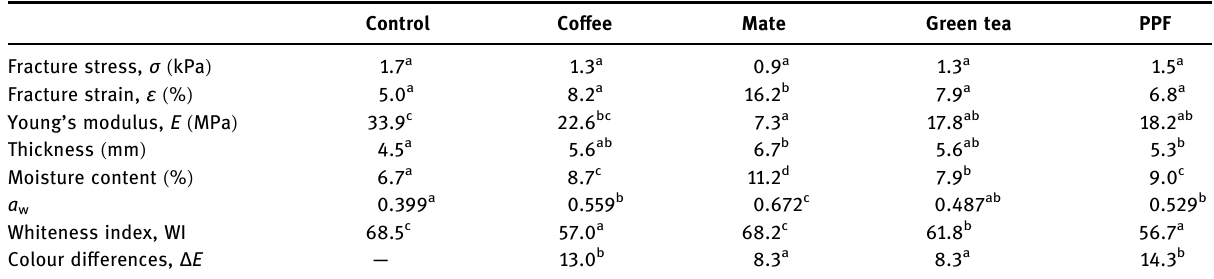
Table 5: Physical characteristics biscuits prepared from the 55:45 wheat fl our:maize starch blend fl our with infusions or with Prosopis chilensis pod fl our ( PPF )